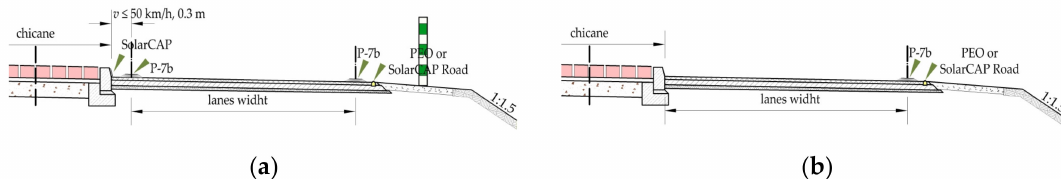
Figure 19. A road cross section with different scheme of road surface markings P-7b “solid white line along the edge of the carriageway”: ( a ) with two P-7b solid white lines (on both sides of the traffic lane) and 1:5 taper ratio; ( b ) with one P-7b solid white line and 1:7 or 1:10 taper